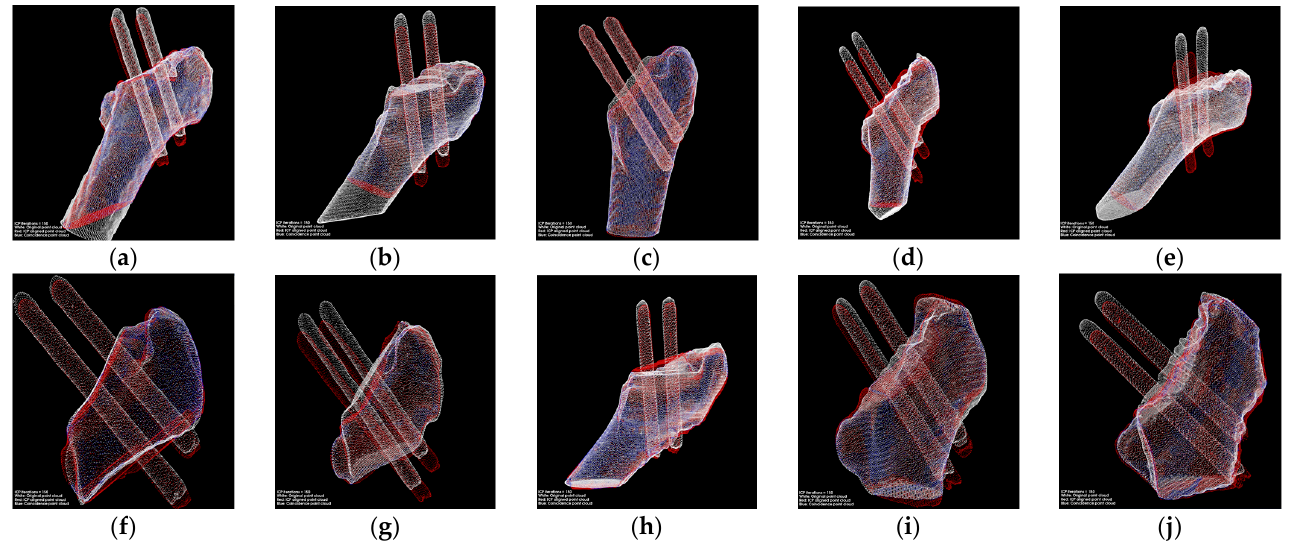
Figure 16. Transformation using the matrix obtained from the registration. ( a – j ) are the point clouds after fine registration for each of the 10 cases. The white point cloud is generated based on the postoperative CT images. The red point cloud is transformed form the point cloud generated based on the CT images scanned after one year. The blue point clouds are the coincident points after point cloud registration.